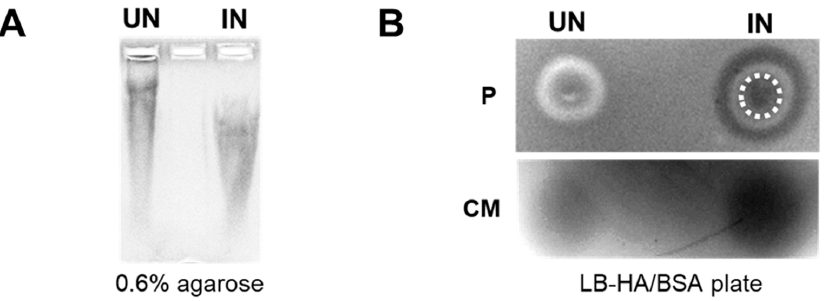
Figure 2. YS-HAse secretes functional HAse following L-arabinose induction. ( A ) In-gel degrada- tion assay. YS-HAse cultures were grown to an OD 600 of 1.5 and UN or IN with 2% L-ara in culture media containing 200 μ g/mL HA and then incubated overnight in a 37 °C shaker. The cultures were centrifuged, and the supernatant was mixed with glycerol and run on a 0.6% agarose gel at 20 V. The gel was stained with Alcian blue and destained with acetic acid to detect the HA smear. ( B ) Plate-clearing assay of YS-HAse. YS-HAse cultures were grown to an OD 600 of 0.7 and UN or IN with 0.125% L-ara. The concentrated pellet (P, top) and isolated and filtered culture media (CM, bottom) were spotted on LB-HA/BSA agar plates and incubated. The plates were then flooded with 1 M glacial acetic acid. The degradation of HA is observed as clear, black areas. A white, dashed circle represents the area of the initial colony